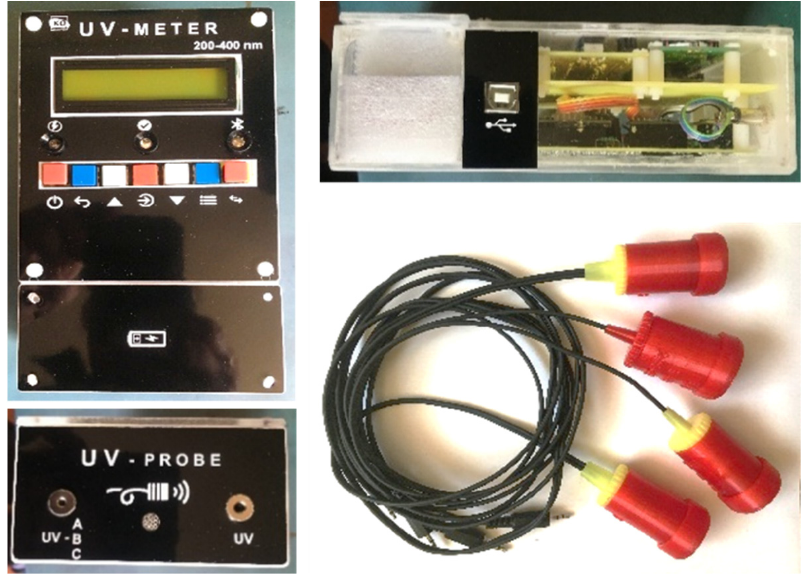
Figure 4. UV spectrum detector device in housing with probes.